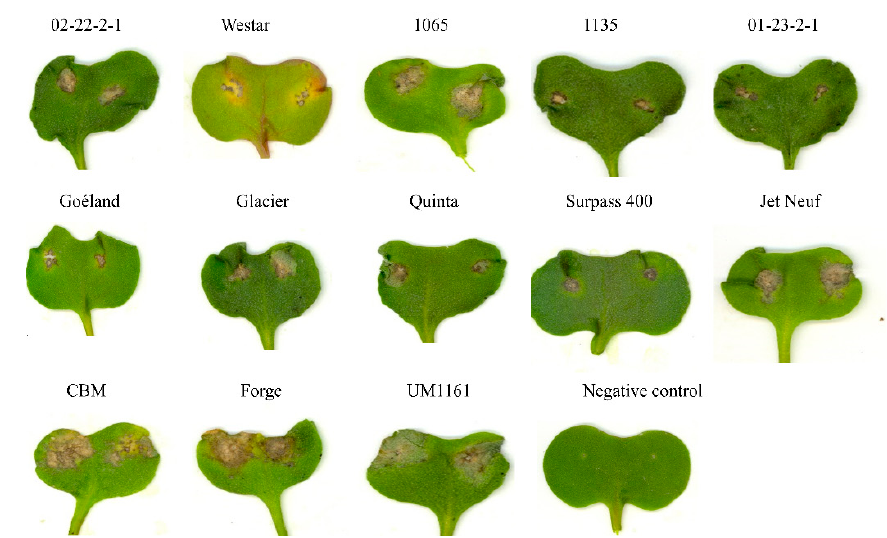
Figure 1. Disease symptoms expressed 14 days’ post-inoculation (dpi) of cotyledons of Brassica napus differential cultivars/lines 02-22-2-1, Westar, 1065, 1135, 01-23-2-1, Goéland, Glacier, Quinta, Surpass 400, and Jet Neuf; two B. juncea lines, a common brown mustard (CBM) and Forge; and one B. rapa line, UM1161(see Table S2 for details of cultivars/lines), with isolate Phl004 of Leptosphaeria biglobosa obtained from the Willamette Valley of Oregon (see Table S1 for details of isolates). Seedlings of the B. napus cv., Westar, inoculated with water were used for the negative treatment. Small, dark brown, necrotic lesions without pycnidia were observed on cotyledons of the B. napus differential cultivars/lines. Table 1. Mean pathogenicity scores and their inferred disease resistance for seedlings of the Brassica species in response to inoculation with the Brassica rapa derived isolates from Willamette Valley, Oregon, USA.